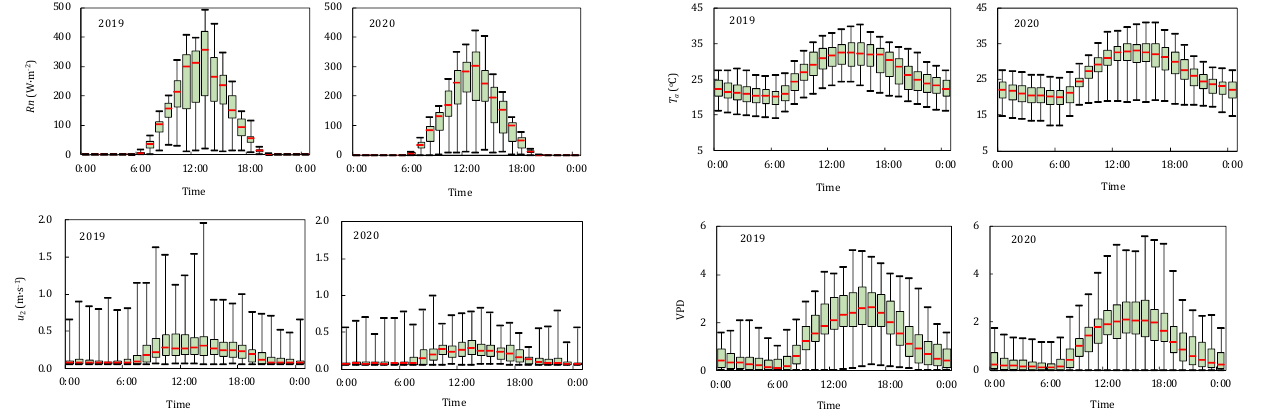
Figure 1. Daily variations of net radiation ( R n ), air temperature ( T a ), wind speed ( u 2 ) and vapor pressure deficit (VPD) in the greenhouse in 2019 and 2020. The upper and lower edges of each element in the box diagram are the maximum and minimum values, respectively. Box upper edge, lower edge and middle red line are the upper quartile, lower quartile and median of the data group, respectively.